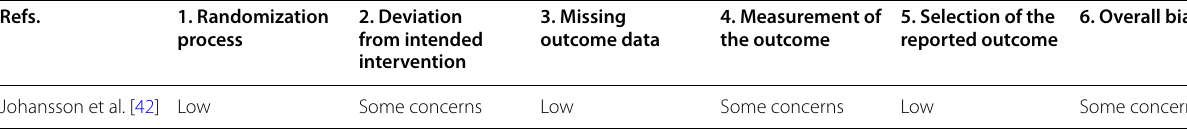
Table 6 Risk-of-bias assessment of the included RCT using RoB 2 tool